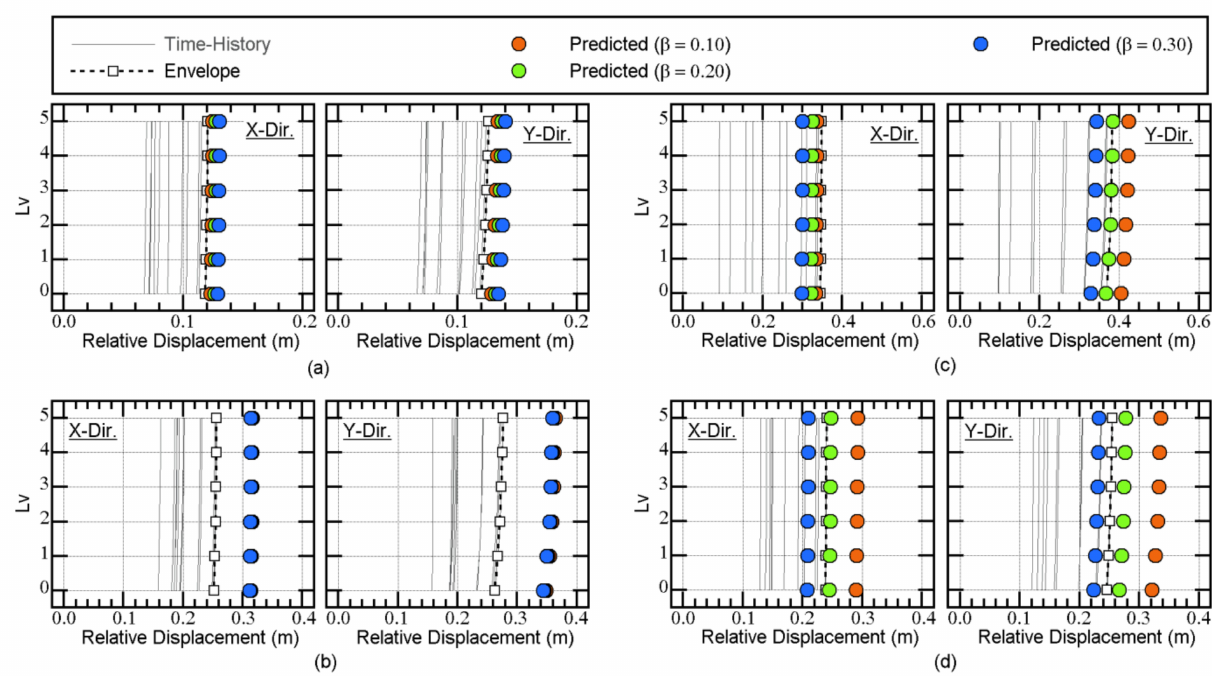
Figure 25. Comparison of the peak relative displacements at X 3A Y 3 (Model-Tf44): ( a ) UTO0414; ( b ) UTO0416; ( c ) TCU; ( d ) YPT.